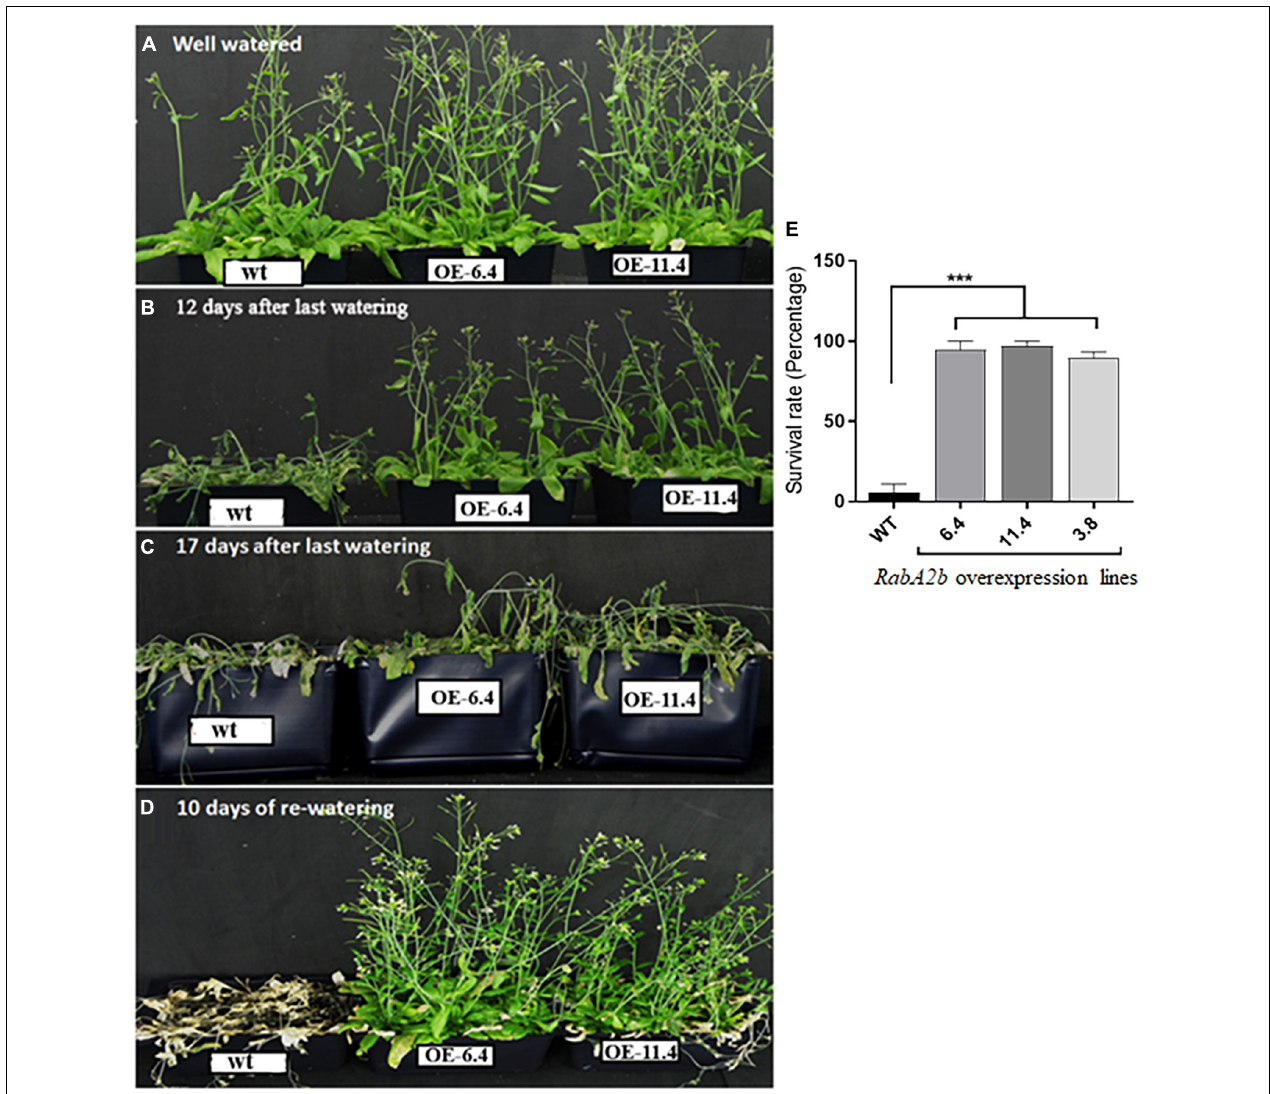
FIGURE 4 | Drought tolerance in RabA2b Overexpressing plants. Transgenic plants constitutively overexpressing RabA2b (lines OE 6.4 and OE 11.4) exhibit a significantly high drought tolerant phenotype compare to wild type plants. (A) RabA2b over-expression and wild type plants were grown under well-watered control conditions for 5 weeks. After 5 weeks, irrigation was withheld for 12 (B) and 17 (C) days to induce gradual drought to the plants. (D) Complete recovery of the overexpressing lines after 10 days of proper irrigation. (E) Graphical representation of survival rate of RabA2b over-expressing lines in the drought stress test. Asterisks indicate significant differences between wild-type (wt) and OE plants. All error bars denote the SD, n = 24 or 36 plants. P < 0.01 (student t -test). Experiments were repeated